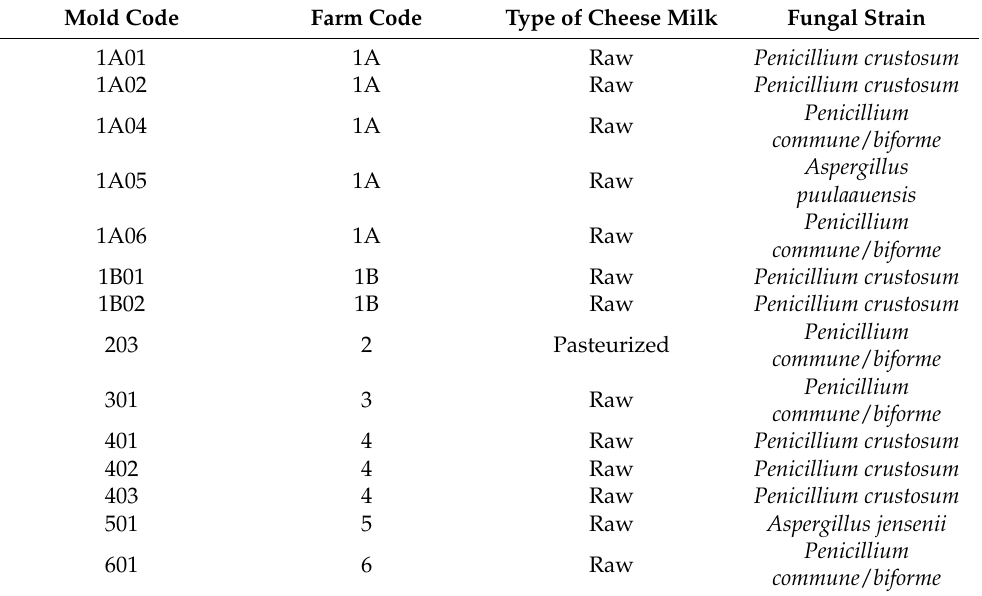
Table 1. Origin and identification of molds isolated from sheep cheese by amplification of β -tubulin BenA gene. Mold Code Farm Code Type of Cheese Milk Fungal